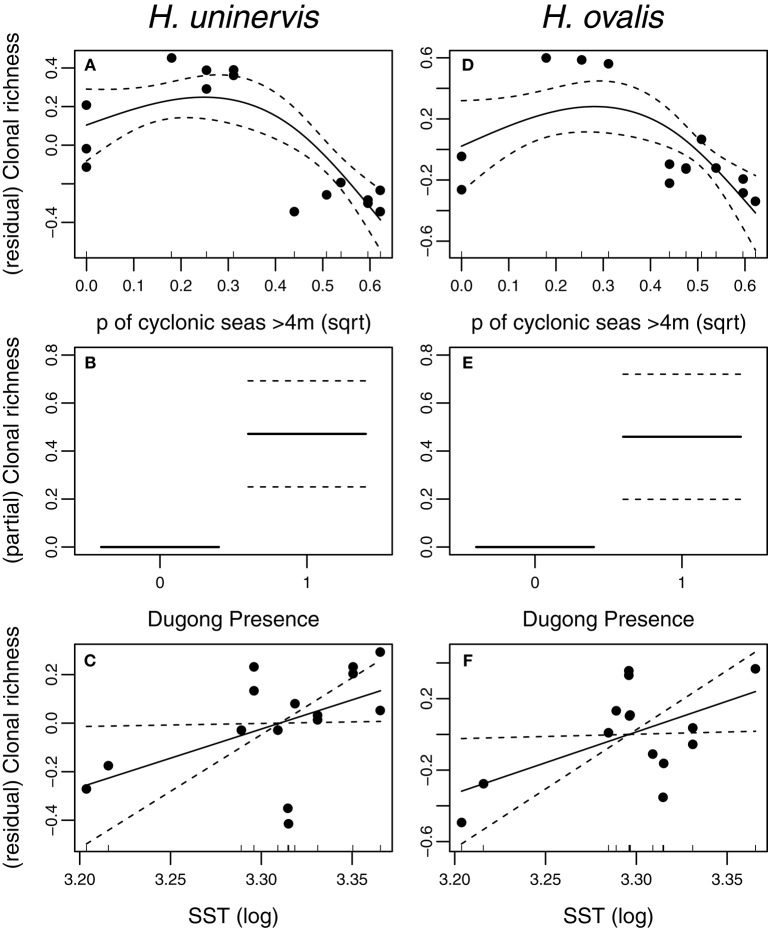
Partial and residual biplots of relationships between predictor variables within two AICc of the top score for H. uninervis and H. ovalis clonal richness. Models were fitted using GAMMs with the solid black line representing the estimated smoothing curve and the dashed lines representing ± SE of the estimate. The most parsimonious model for H. uninervis was (A) probability of cyclonic seas. There were two most parsimonious models for H. ovalis
(D) Probability of cyclonic seas, and (E) Dugong presence. SST (Sea surface Temperature) (C,F) was included in a top model when combined with dugong (B,E) for both species.